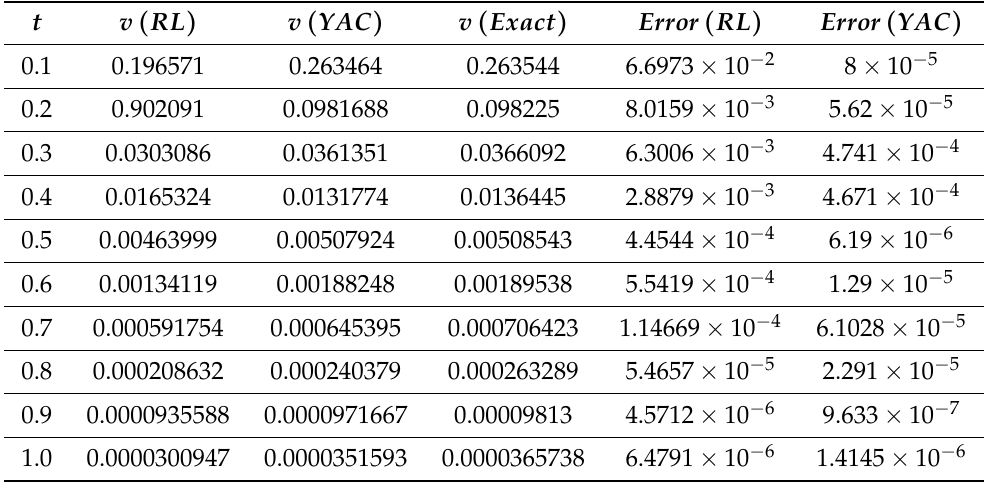
Table 1. Comaprison of α − HATM Solution in sense of YAC derivative operator, RL derivative operator and exact solution for Case